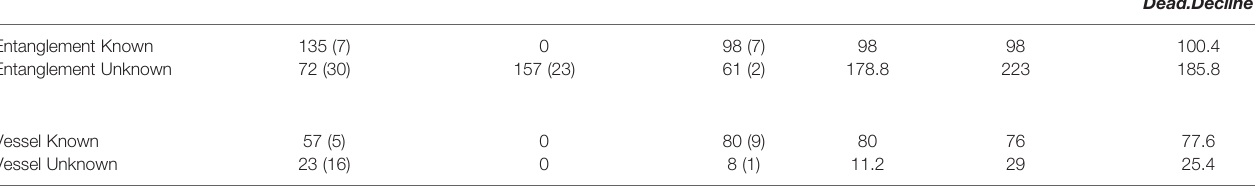
The number of known and unknown outcome cases assigned speci fi c MSI values by biologists, and (in parentheses), the number of same cases where RF predicted probabilities of Dead.Declineindicateaninjurycategoryincon fl ictwithcurrentprotocols.Forexample,biologistsassigned135knownoutcomeentanglementsasnon-seriousinjurieswithaMSIvalue=0 and7ofthesecaseshadRFprobabilities ofDead.Decline>0.5, consistentwith thede fi nitionofaseriousinjury.ThesumofassignedMSIvalues, RFmajoritypredictionsofDead.Decline, andRFprobabilities ofDead.Declinearealsoshown.Unknown outcomevesselstrikecases assignedproratedMSI valuesof0.20,0.36,0.52,and0.56were toorare (n=7cases, ∑